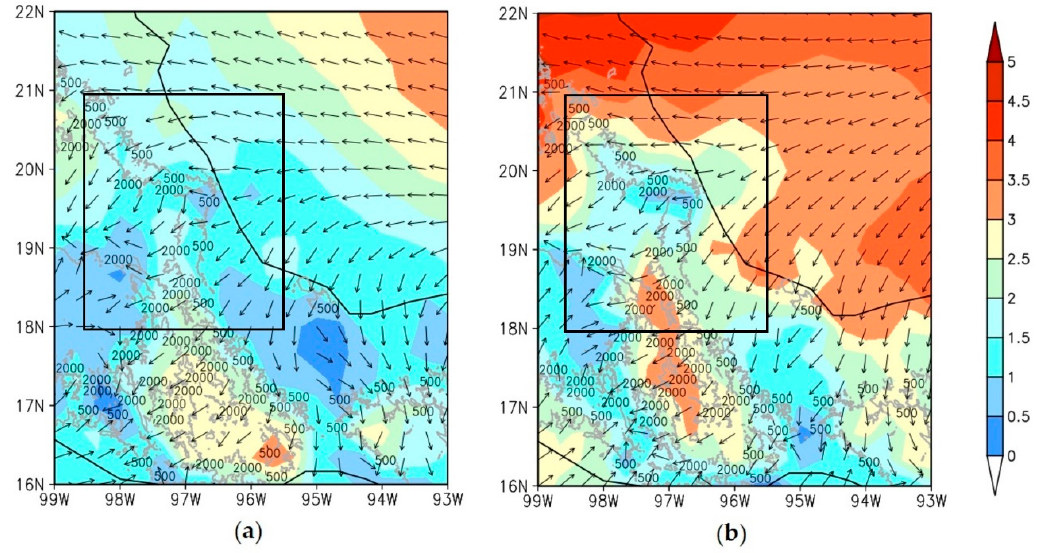
Figure 6. Average wind field (m s − 1 ) at 10 m for ( a ) 13 LT and ( b ) 19 LT for summer (May–October), using NARR reanalysis data for the period of 1979–2012. For clarity, the vectors correspond only to the wind direction; the magnitude is indicated by shaded. The contours of 500 and 2000 m.a.s.l. are shown.